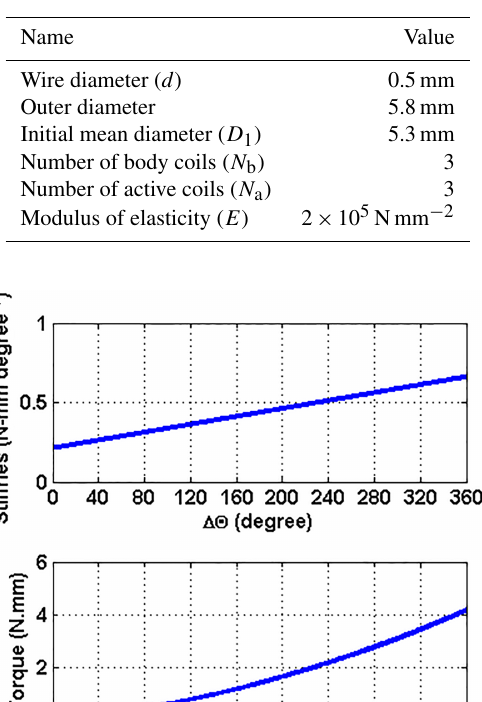
Table 1. Physical properties for the torsion spring of material stain steel.